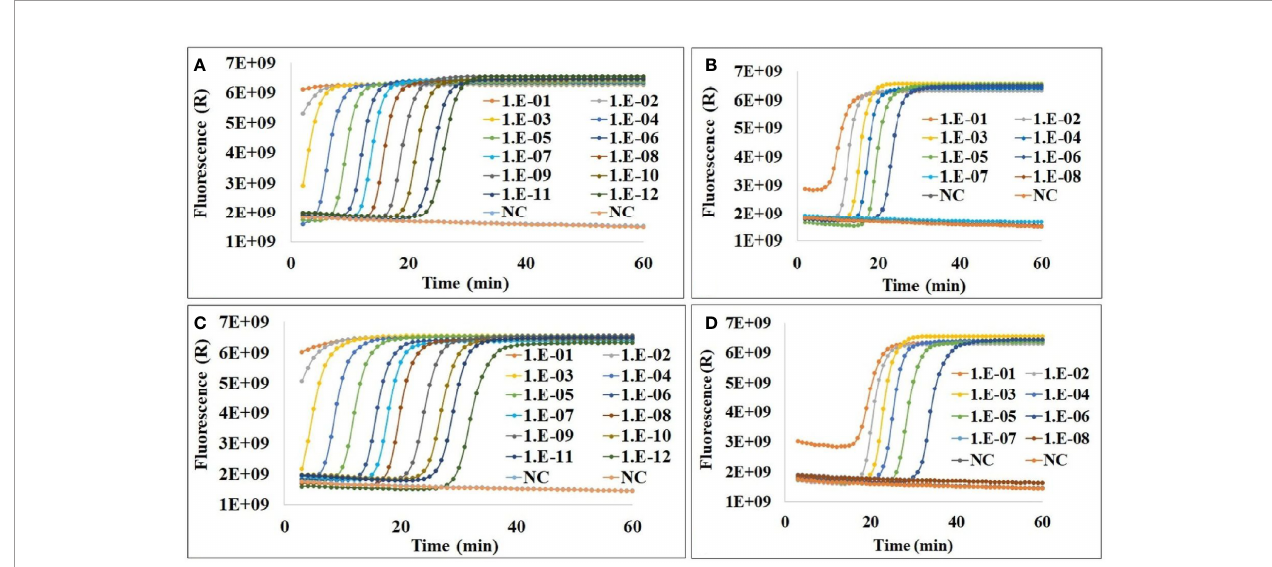
FIGURE 2 | The elimination of carryover contamination in Cod-UNG-rRT-LAMP reaction (A) containing 0.3 mM dUTP and 0.05 mM dTTP and using log 10 dilution of an ampli fi ed product from an rRT-LAMP reaction (containing only dTTP) as control template; (B) containing 0.3 mM dUTP and 0.05 mM dTTP and using log 10 dilution of an ampli fi ed product from a Cod-UNG-rRT-LAMP reaction (containing 0.3 mM dUTP and 0.05 mM dTTP) as template; (C) containing 0.35 mM dUTP and 0 mM dTTP and using log 10 dilution of the ampli fi ed product from the rRT-LAMP reaction (containing only dTTP) as control template; and (D) containing 0.35 mM dUTP and 0 mM dTTP and using log 10 dilution of the ampli fi ed product from the Cod-UNG-rRT-LAMP reaction (containing 0.35 mM dUTP and 0 mM dTTP) as